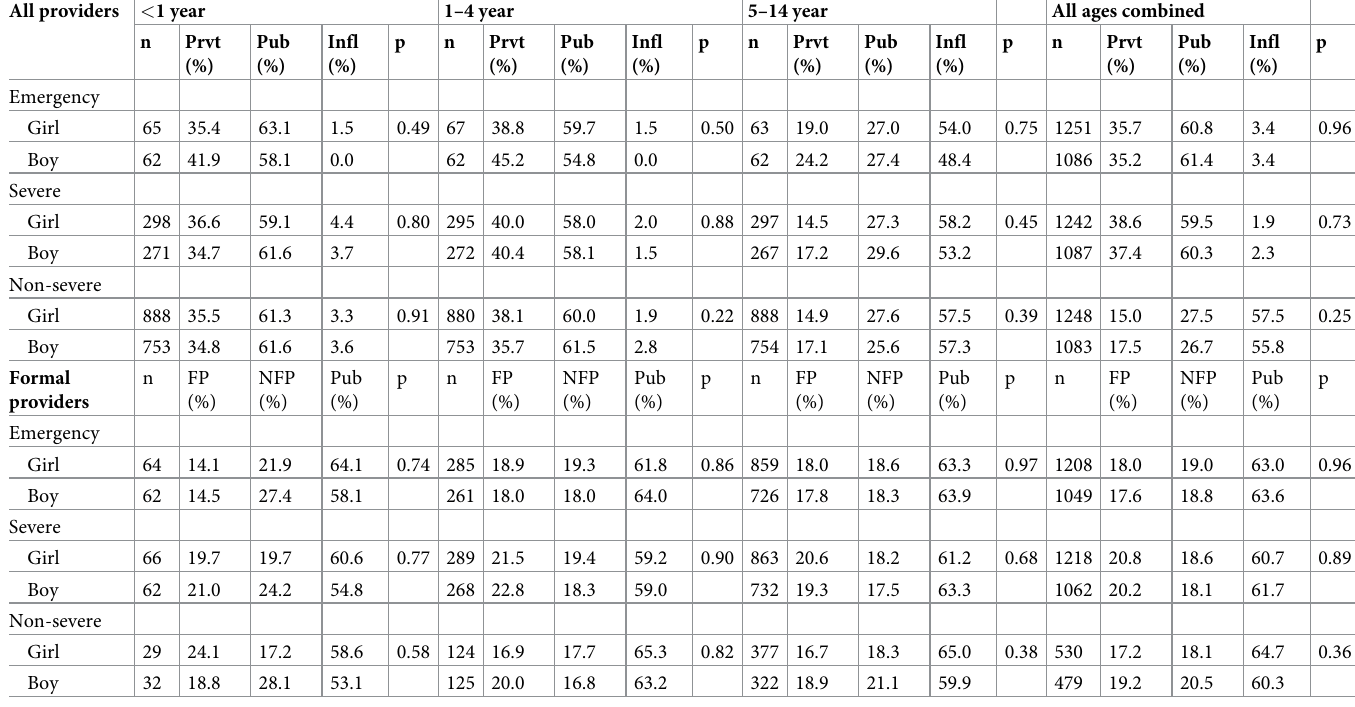
Table 4. Pearson’s χ 2 test of age and gender (girls vs. boys) stratification in the choice of providers by health condition among urban